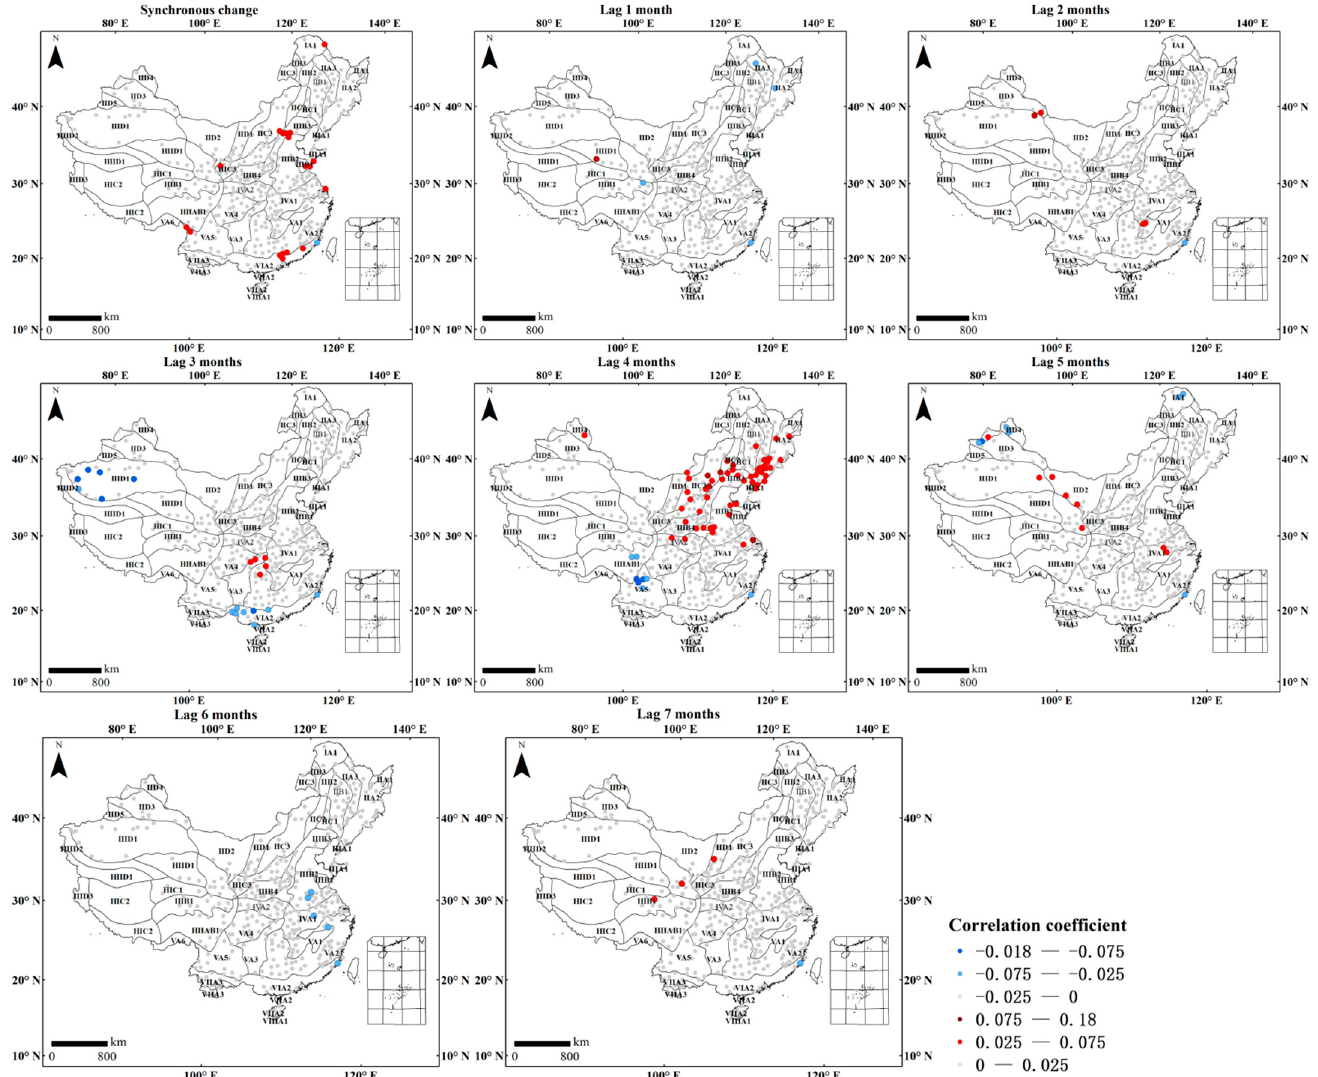
Figure 6. Severity and time lag of drought due to the weakest El Niño event (identified by MEI).